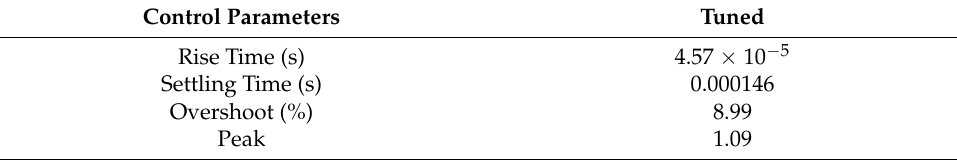
Table 4. PID performance and